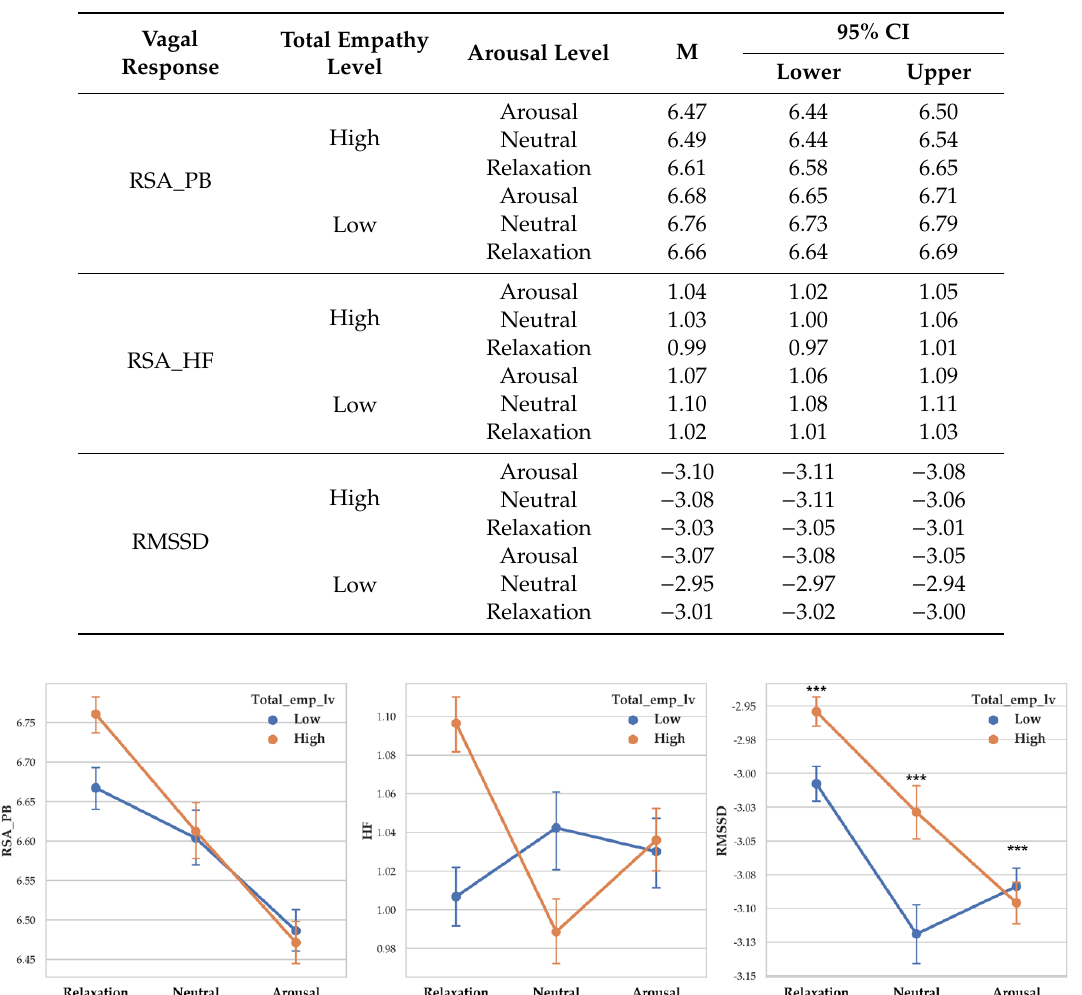
Table 11. Descriptive statistics for vagal response depending on total empathy level and arousal. M = Mean, SD = Standard deviation. 95% CI = 95% of confidence interval.